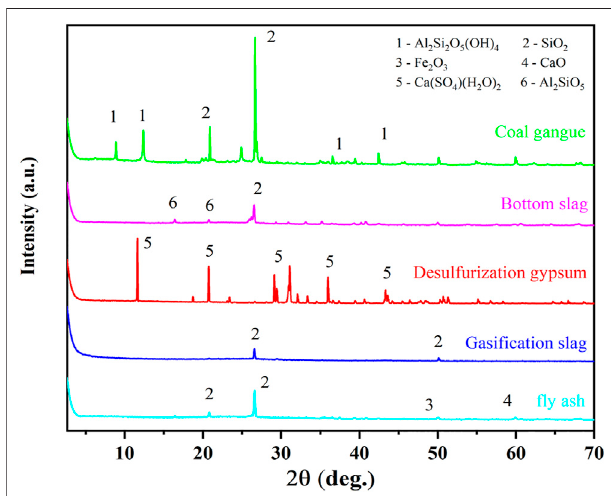
FIGURE 1 | X-ray diffraction (XRD) of coal based solid waste fi lling